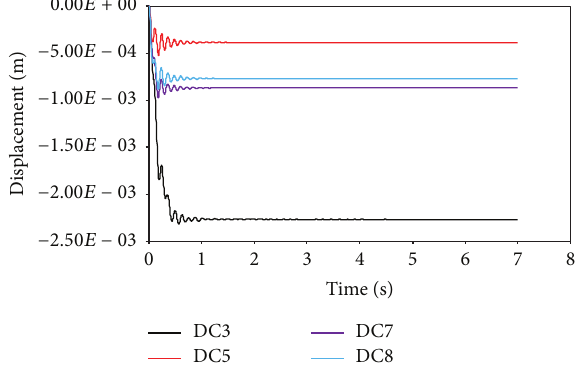
Figure 8: Time history diagram of surface displacement at the monitoring points surrounding the foundation pit. West monitoring site DC3 (black), south monitoring site DC5 (red), east monitoring site DC7 (purple), and north monitoring site DC8